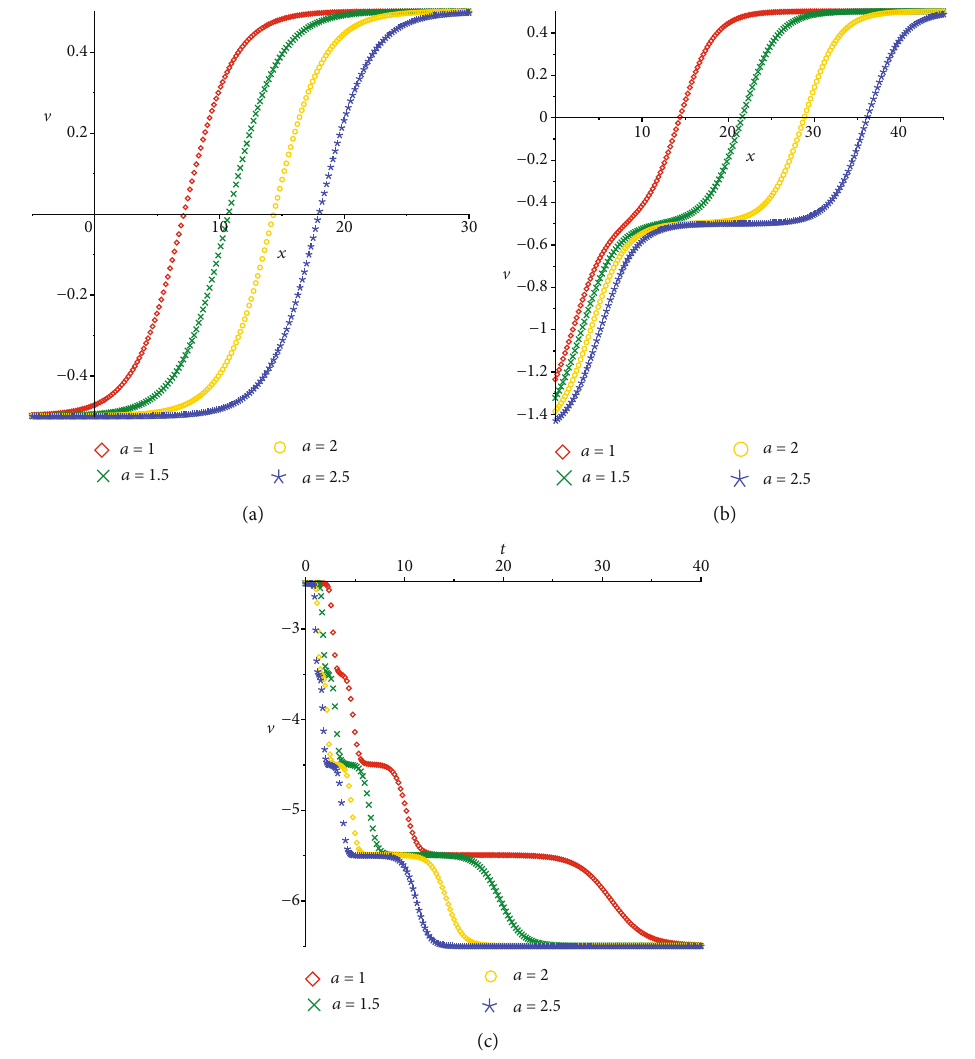
Figure 14: (a) Single shock wave for δ = 0 : 9, l for δ = 0 : 9, l